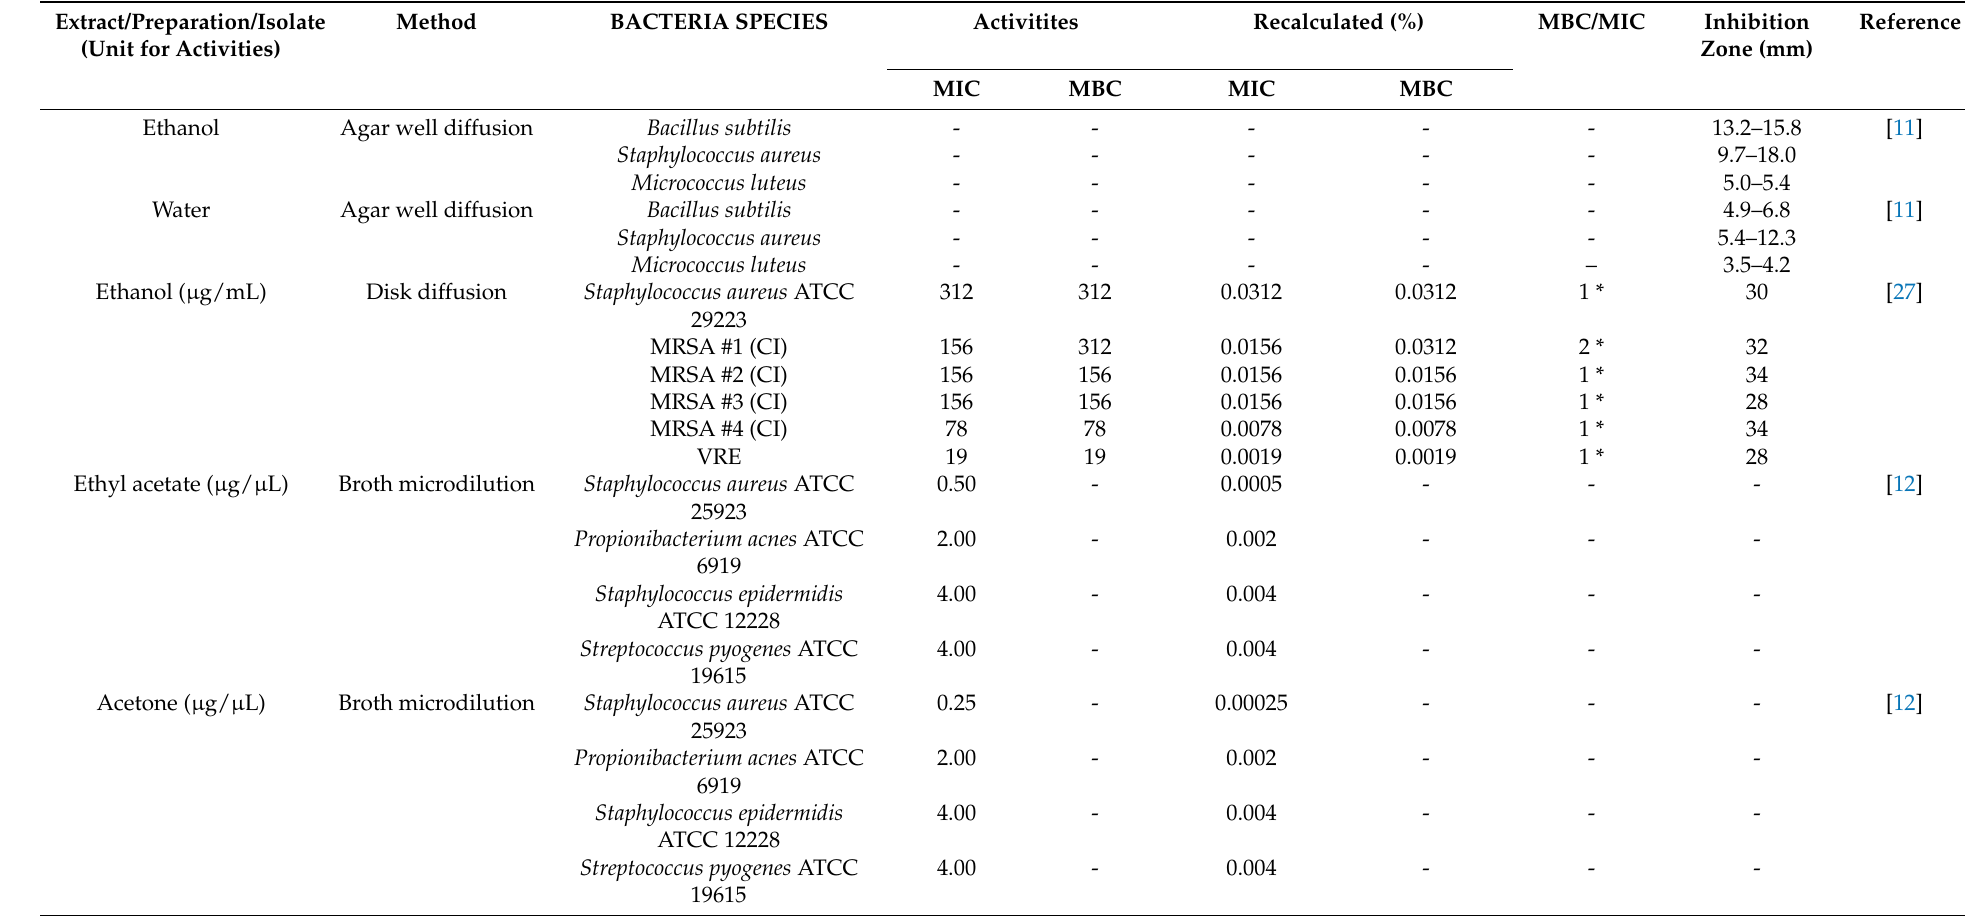
Table 3. Piper betle against Gram-positive